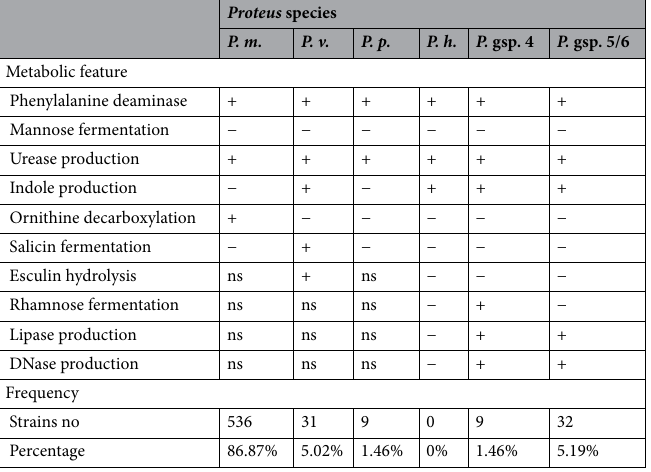
Table 1. Biochemical features and frequency of Proteus species occurrence (including the isolates reported earlier 13–20 ). ns, not studied. P.m., Proteus mirabilis. P.v., Proteus vulgaris. P.p., Proteus penneri. P.h., Proteus hauseri. P. gsp., Proteus